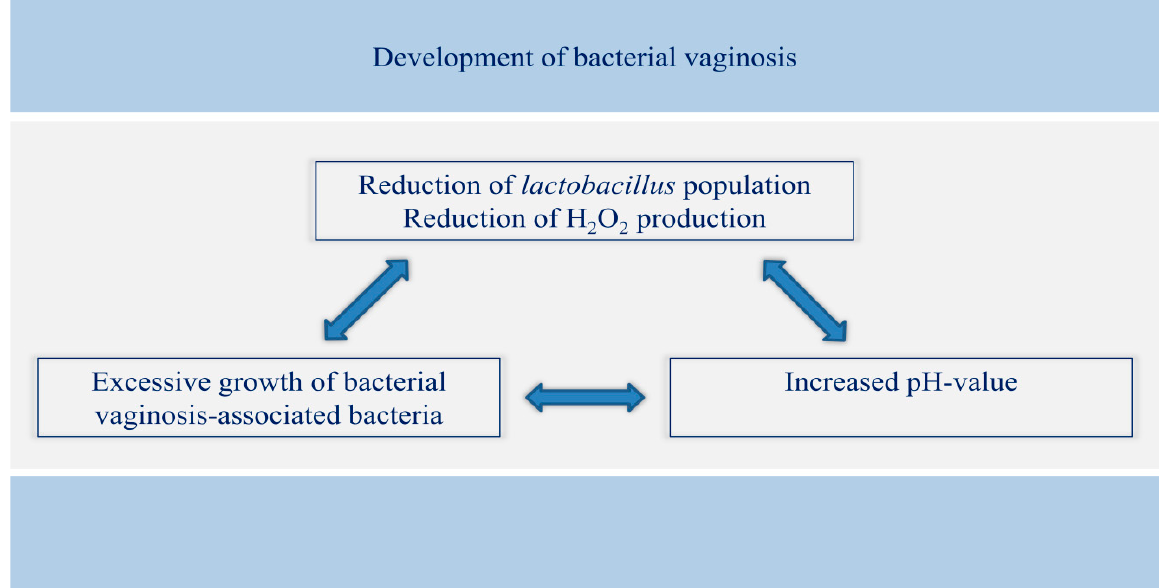
Figure 3. Correlation between Lactobacillus , pH value, and pathogenic germs in the emergence of bacterial vaginosis.